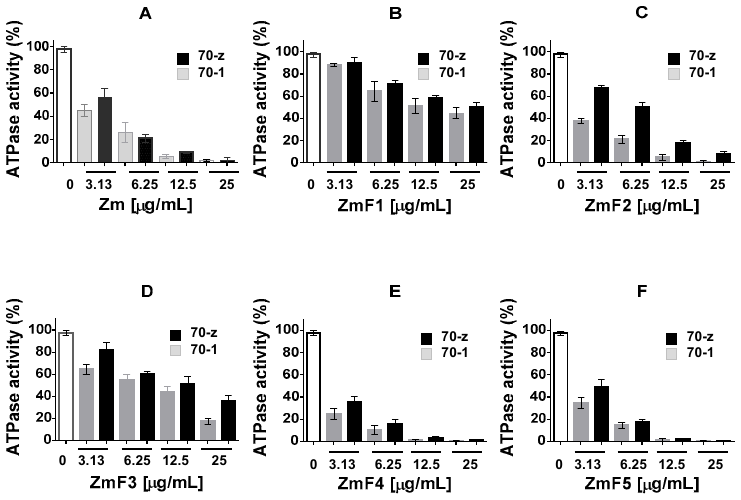
Figure 4. Inhibition of the basal ATPase activity of PfHsp70-1 and PfHsp70-z by Z. mucronata extracts. The basal ATPase of PfHsp70-1 (70-1)/PfHsp70-z (70-z) were analysed in the presence of increasing amounts of the various plant extracts. The values were normalized to basal ATPase of each protein obtained in the absence of plant extract. The effects of the variable concentrations of plant extracts were then investigated and presented: ( A ) Zm, ( B ) ZmF1, ( C ) ZmF2, ( D ) ZmF3, ( E ) ZmF4, ( F ) ZmF5. Standard deviations obtained from three replicate assays are shown.